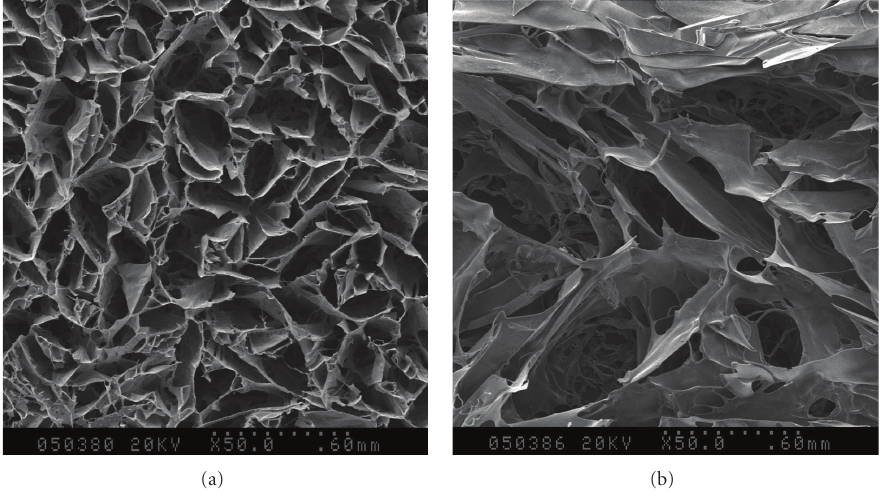
Figure 1: Macrostructure of PSFFs by SEM.